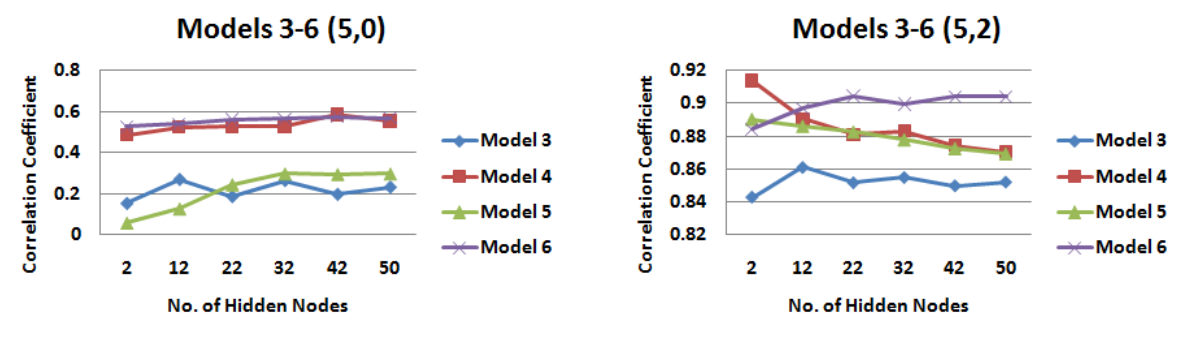
Figure 14. Correlation coefficients for input models 3–6 for 5 days of rainfall information and 0 and 2 days water level information— ( a ) Models 1 and 2 (5,0) ( b ) Models 1 and 2 (5,2)